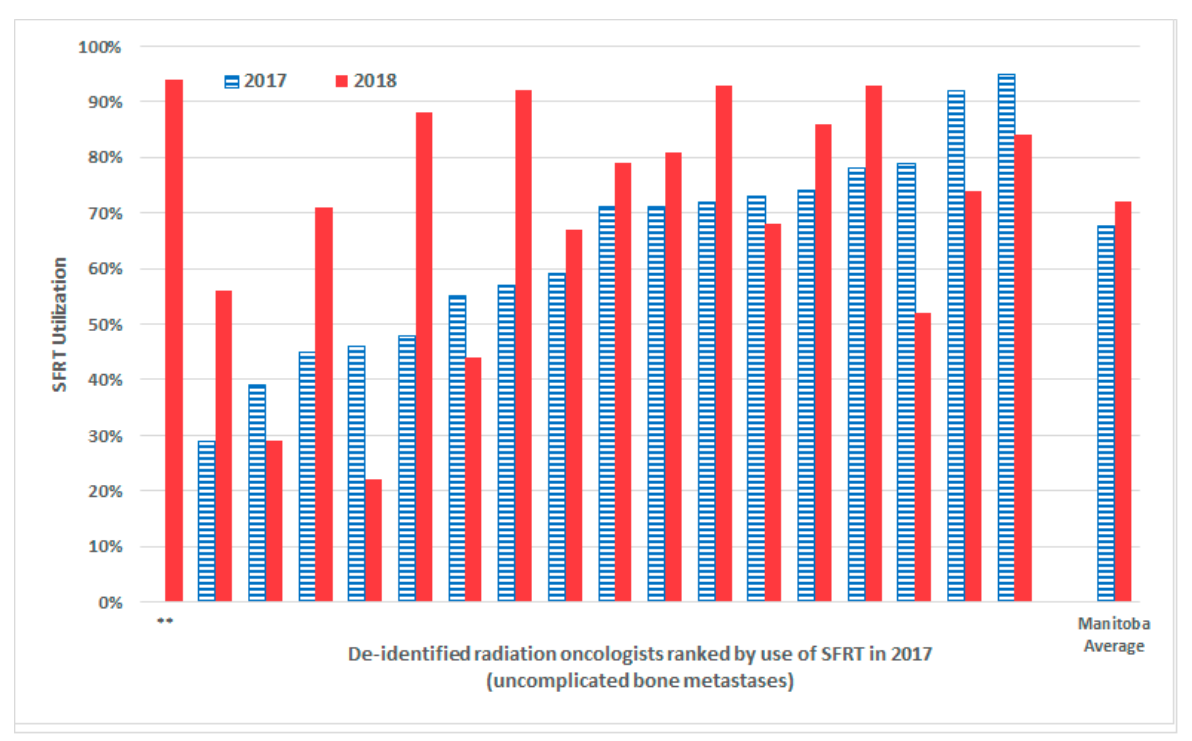
Figure 2. Proportion of SFRT utilized by de-identified individual radiation oncologists for uncomplicated bone metastases in 2017 and 2018 in Manitoba (**: Radiation oncologist joined the team in 2018 and has no 2017 comparison point). Table 3. Year-over-year change in proportion of bone metastases treated with SFRT by individual radiation oncologists for uncomplicated bone metastases. Only clinicians who participated in the KT campaign (17/18) are included.